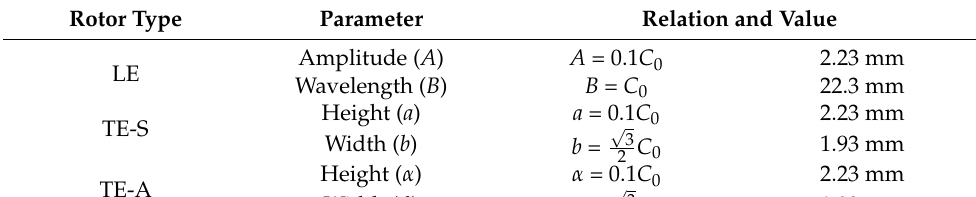
Table 1. Parameters of different rotors models with bionic edges designs.